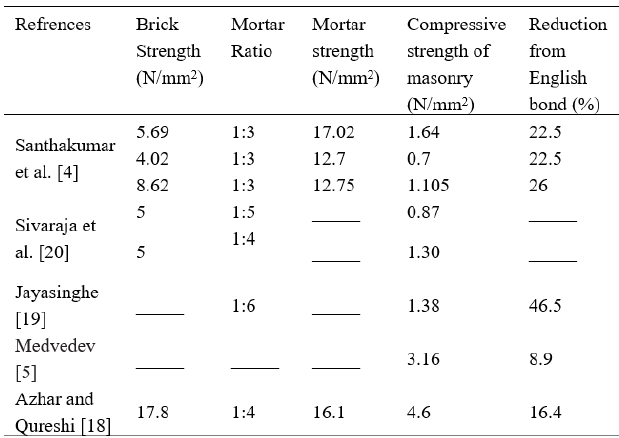
Summary of compressive strength of RTB and comparison with English Bond